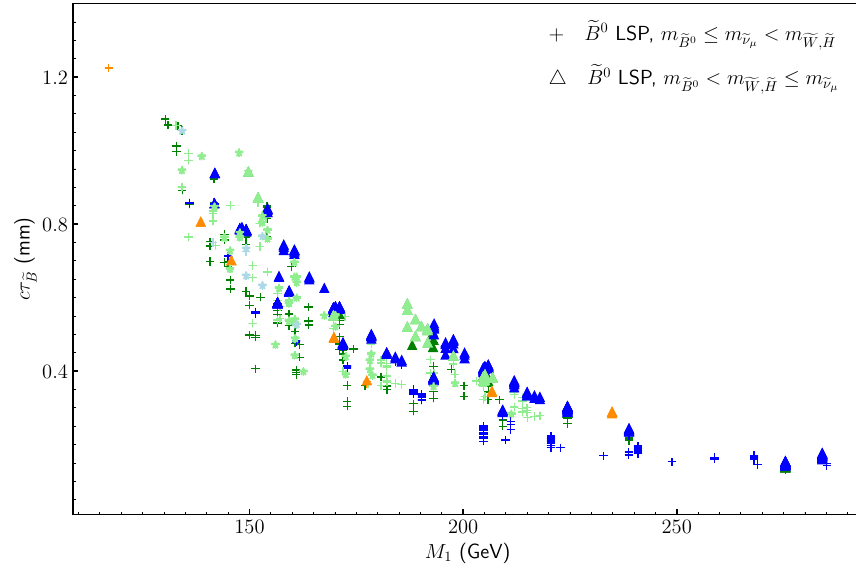
Fig. 10 Proper decay length of the bino LSP c τ (cid:2) B 0 versus M